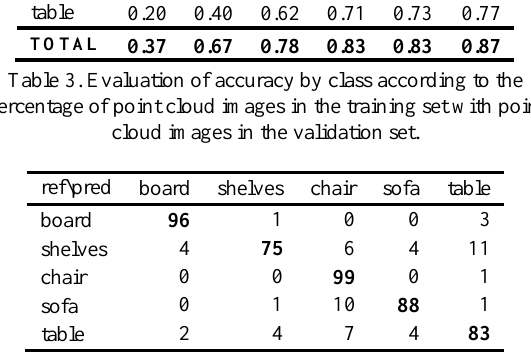
Table 4. Confusion matrix of CNN trained with online images in the validation set.